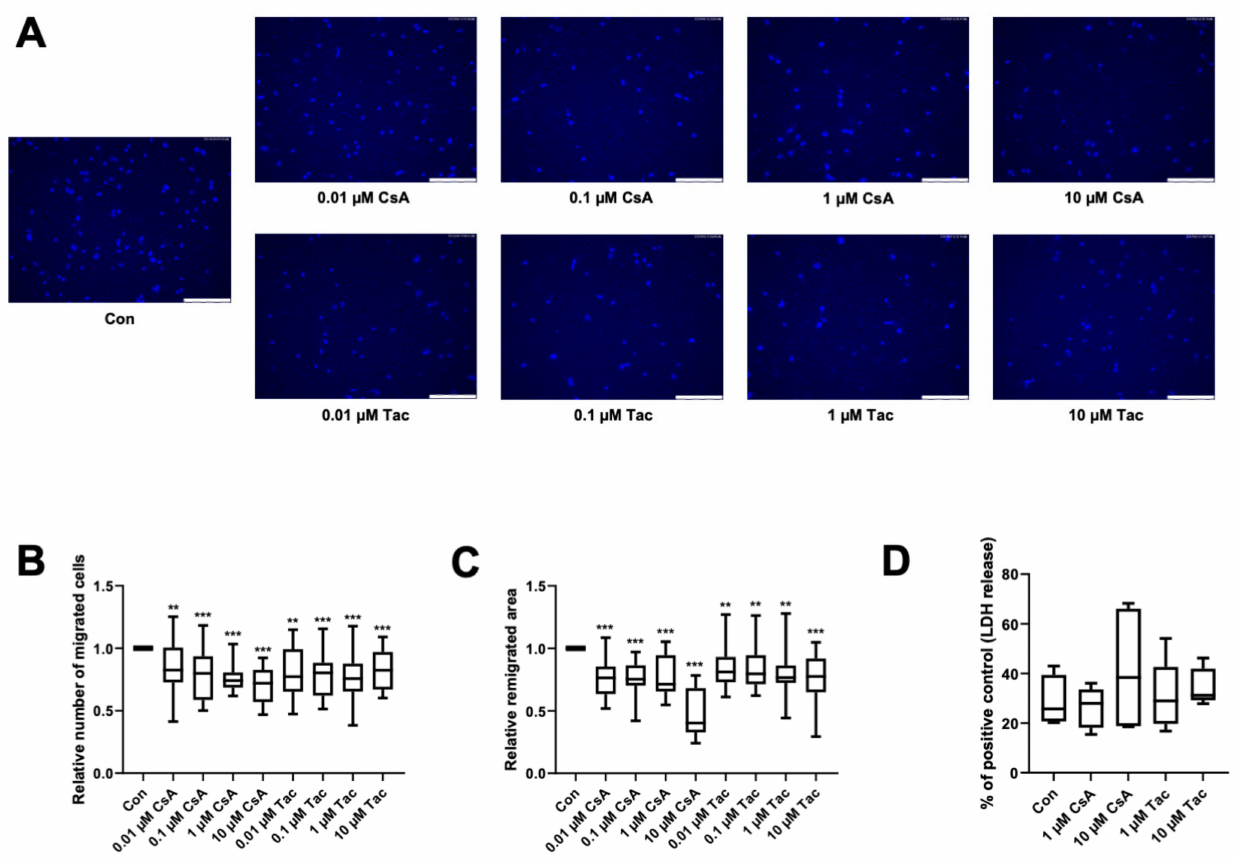
Figure 2. Cyclosporine A (CsA) and tacrolimus (Tac) impaired ECFC migration. ( A ) Representative images of DAPI-stained migrated ECFCs treated with CsA or Tac (0.01–10 µ M) in a chemotaxis assay, scale bar 150 µ m. ( B ) ECFCs showed a significantly lower directional migration in presence of CsA or Tac after 4 h. Numbers of DAPI-stained migrated cells on the bottom side of the membranes were counted in each picture, control group set as 1. n = 20. ( C ) CsA or Tac treatment (0.01–10 µ M) of ECFCs diminished wound closure assessed as remigrated area after 18 h compared to control, control group set as 1. Representative images can be found in Supplemental Figure S2. n = 15–16. ( D ) CsA or Tac (1 µ M or 10 µ M) did not lead to significantly higher LDH release after 18 h, positive control set as 100%, n = 9. Con—control; CsA—cyclosporine A; Tac—tacrolimus. ** p < 0.01, *** p <